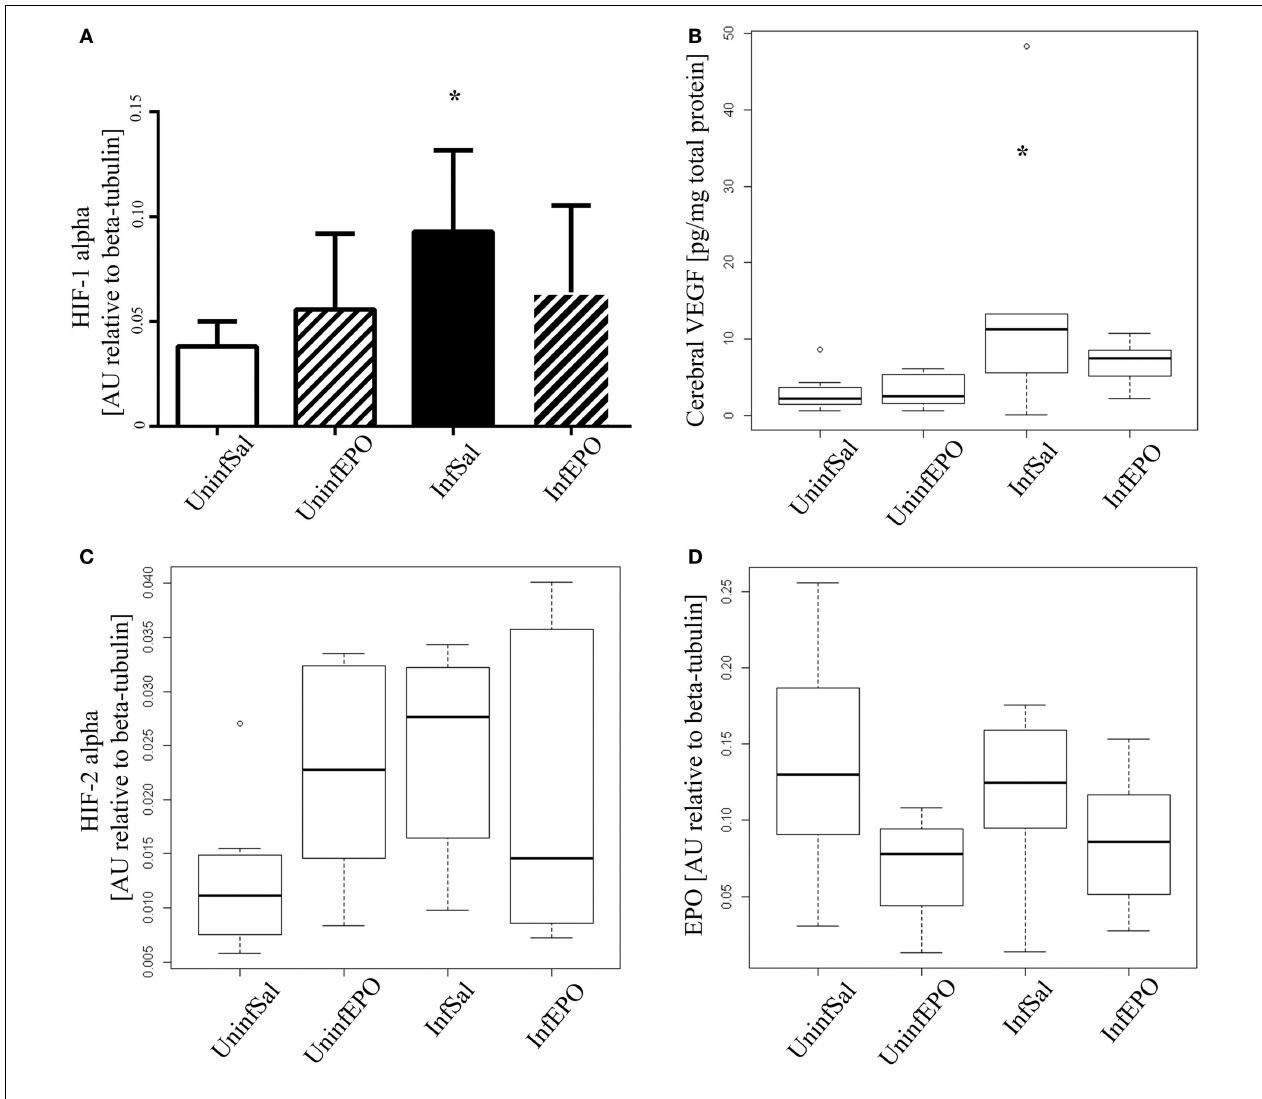
FIGURE 2 | Cerebral expression of HIF-1 α ,VEGF, HIF-2 α , and EPO. (A) HIF-1 α levels were significantly increased in InfSal mice compared with UninfSal ( p = 0.04).The other groups were statistically indistinguishable. (B) VEGF was analyzed with ELISA, showing a significant increase in InfSal mice compared with uninfected mice ( p = 0.02). InfEPO was increased though not statistically significantly.